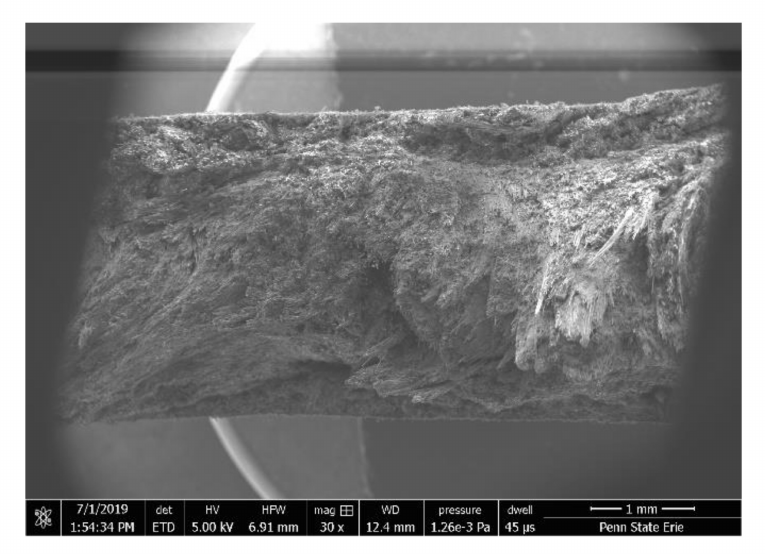
Figure 4. SEM image of the sample with 50% CF3, showing the frozen layer at the top and bottom of the sample.